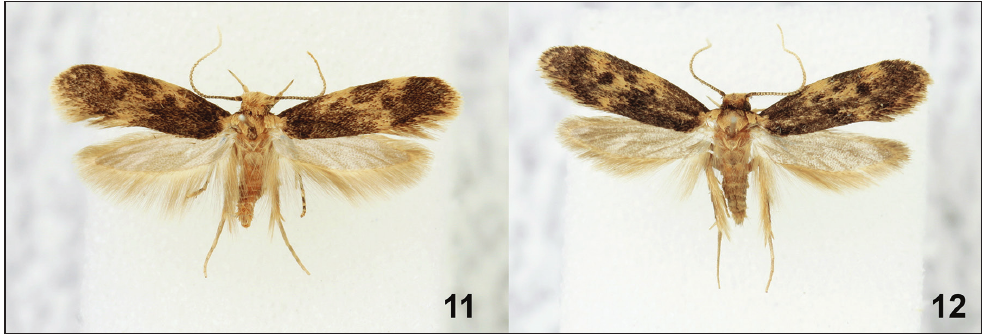
Figures 11–12. Male Portuguese specimens: 11. Louriçal, Pombal, Coimbra; 12. Paúl de Madriz, Soure,